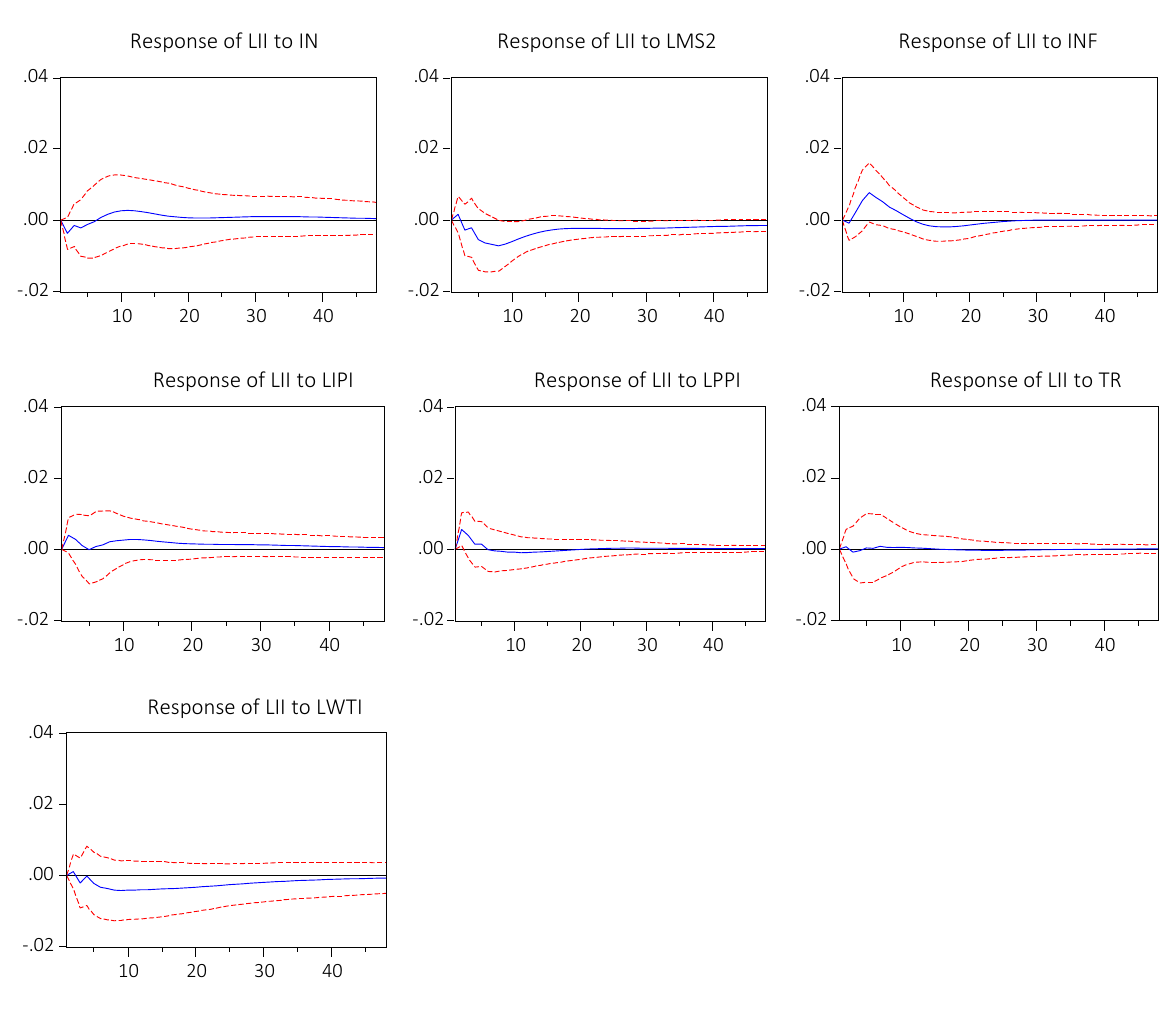
Figure 3. Response of industrial index to macroeconomic